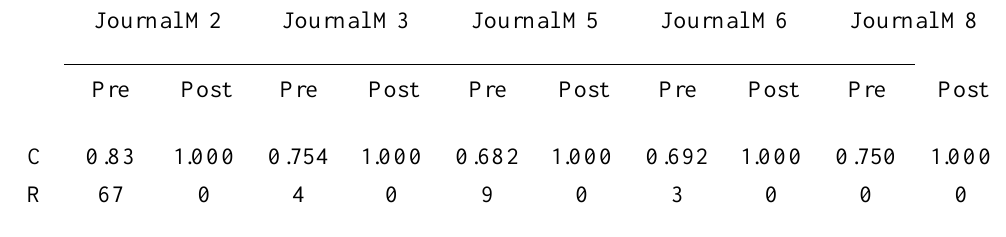
Inter-Rater Reliability for Journals